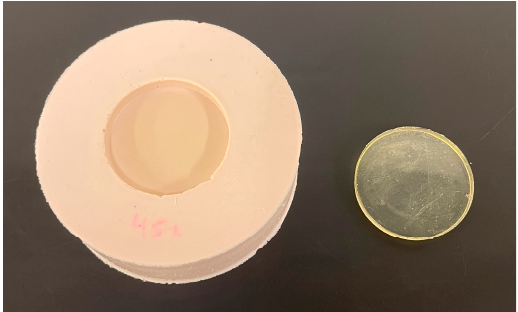
Figure 1. Example of a silicone mould used for the fabrication of xerogels and one of the transparent, glass-like discs prepared.